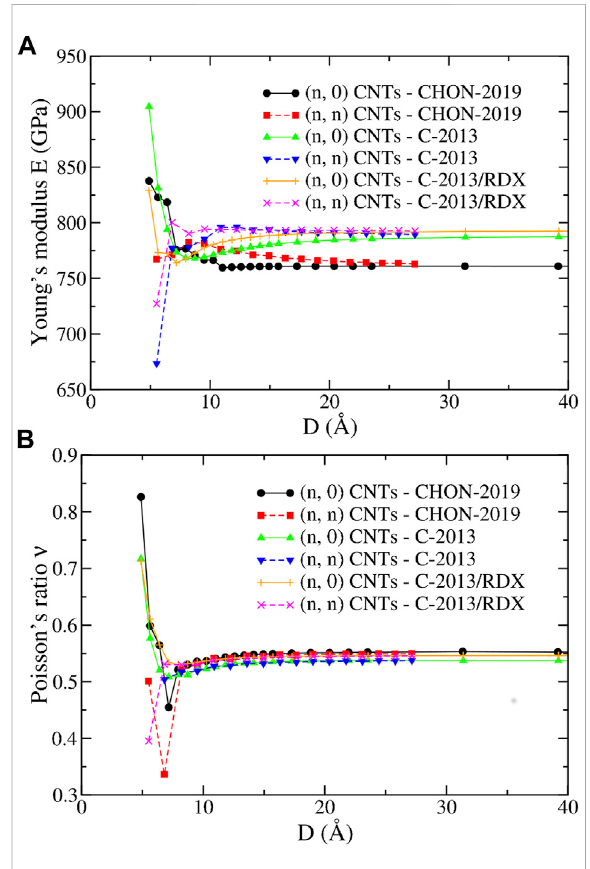
FIGURE 10 (A) The Young ’ s modulus E and (B) the Poisson ’ s ratio ] as a function of the diameter D for the ( n , 0) and ( n , n ) CNTs of the present study predicted by the CHON-2019, C-2013 and GR- RDX-2021